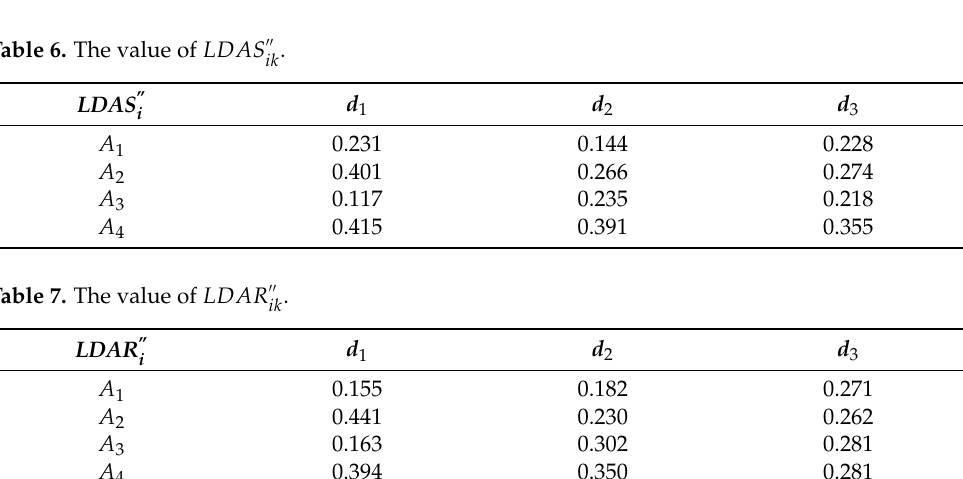
Table 6. The value of LDAS (cid:48)(cid:48)